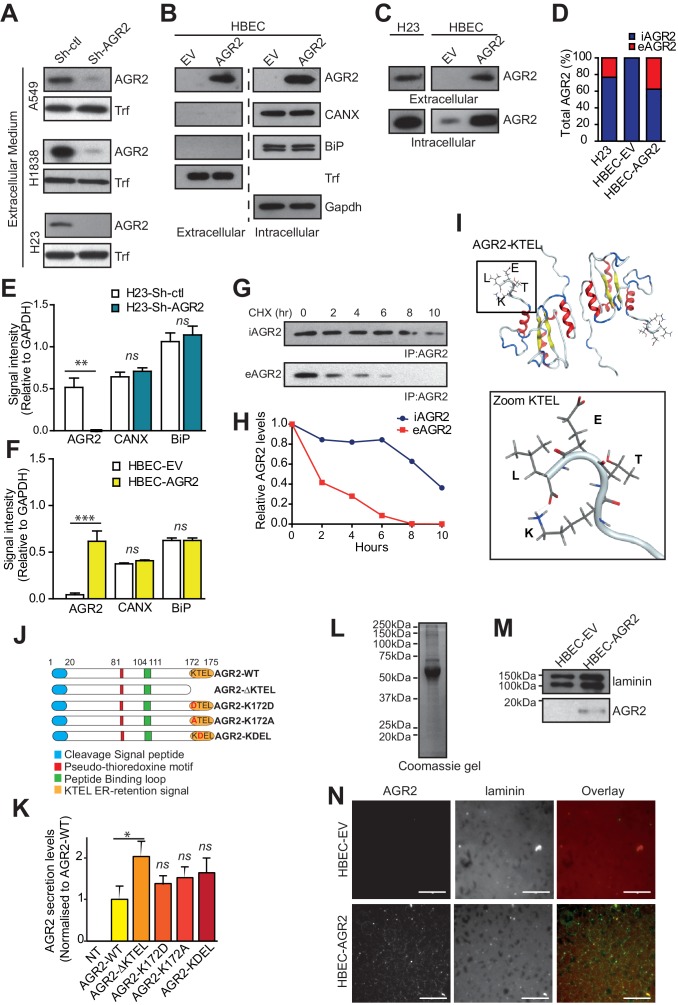
AGR2 is secreted in the extracellular medium and interacts with extracellular matrix (ECM).(A) Proteins in the conditioned medium were subjected to immunoblotting with anti-AGR2 antibody. Transferrin (Trf) concentrations are shown as the loading control. One representative experiment (n = 3) is shown. (B) Up-regulation of AGR2 protein concentrations in extracellular and intracellular lysates of HBEC infected with either empty vector (HBEC-EV) or AGR2 (HBEC-AGR2), as analyzed by western blot. Trf concentrations are shown as the loading control for extracellular lysates and GAPDH concentrations are shown as loading control for intracellular lysates. The transmembrane protein Calnexin (CANX) and the KDEL containing protein BiP are shown as control ER-resident proteins in extracellular and intracellular lysates. One representative experiment (n = 3) is shown. (C) Levels of extracellular and intracellular AGR2 protein detected by immunoblotting in H23 organoids as compared to the levels of extracellular and intracellular AGR2 protein in HBEC organoids expressing (HBEC-AGR2) or not (HBEC-EV) AGR2. One representative experiment (n = 3) is shown. (D) The stacked bars show the relative percentage of intracellular vs extracellular AGR2. (E,F) Quantification of the relative signal intensity of AGR2 and two other ER-resident proteins (CANX and Bip) compared to GAPDH in intracellular lysates from AGR2-depleted and control H23 organoids (E) or from AGR2 overexpressing and control HBEC organoids (F). (G) H23 cells were treated with CHX (cycloheximide) for the indicated periods (hours) before cell lysates and extracellular medium were prepared as described in Materials and methods. AGR2 was immunoprecipitated in intracellular and extracellular lysates with a monoclonal AGR2-specific antibody and then detected by immunoblot analysis. (H) The densitometric quantification of the remaining protein expressed as relative to the starting amount is shown in the diagram. (I) Structure model of the KTEL motif (K172-T173-E174-L175) of AGR2, PDB ID 2LNS. The four residues (KTEL) of the ER retention motif are shown in the zoom (bottom panel). (J) Schematic representation of the AGR2 point or deletion mutants (red: thioredoxin-like domain; orange: ER-retention motif). (K) Impact of the thioredoxin-like domain and of the ER-retention motif on AGR2 secretion. Quantification of the relative amount of secreted AGR2 for all the mutants. AGR2 secretion was normalized in each experiment and is compared to control non-transfected HEK-293T cells (NT). Data are mean ± SEM. *p<0.05. (L–M) Cell-derived matrices were generated from HBEC-EV and HBEC-AGR2 cells after 8 days of culture. Proteins were solubilized, separated by SDS-PAGE and stained with Coomassie Blue (L) or immunoblotted for Laminin or AGR2 (M). (N) Cell-derived matrices from HBEC-EV and HBEC-AGR2 cells were processed for immunofluorescence, stained with anti-laminin (red) and anti-AGR2 antibodies (green) and images were collected by microscopy. Scale bars: 100 μm.